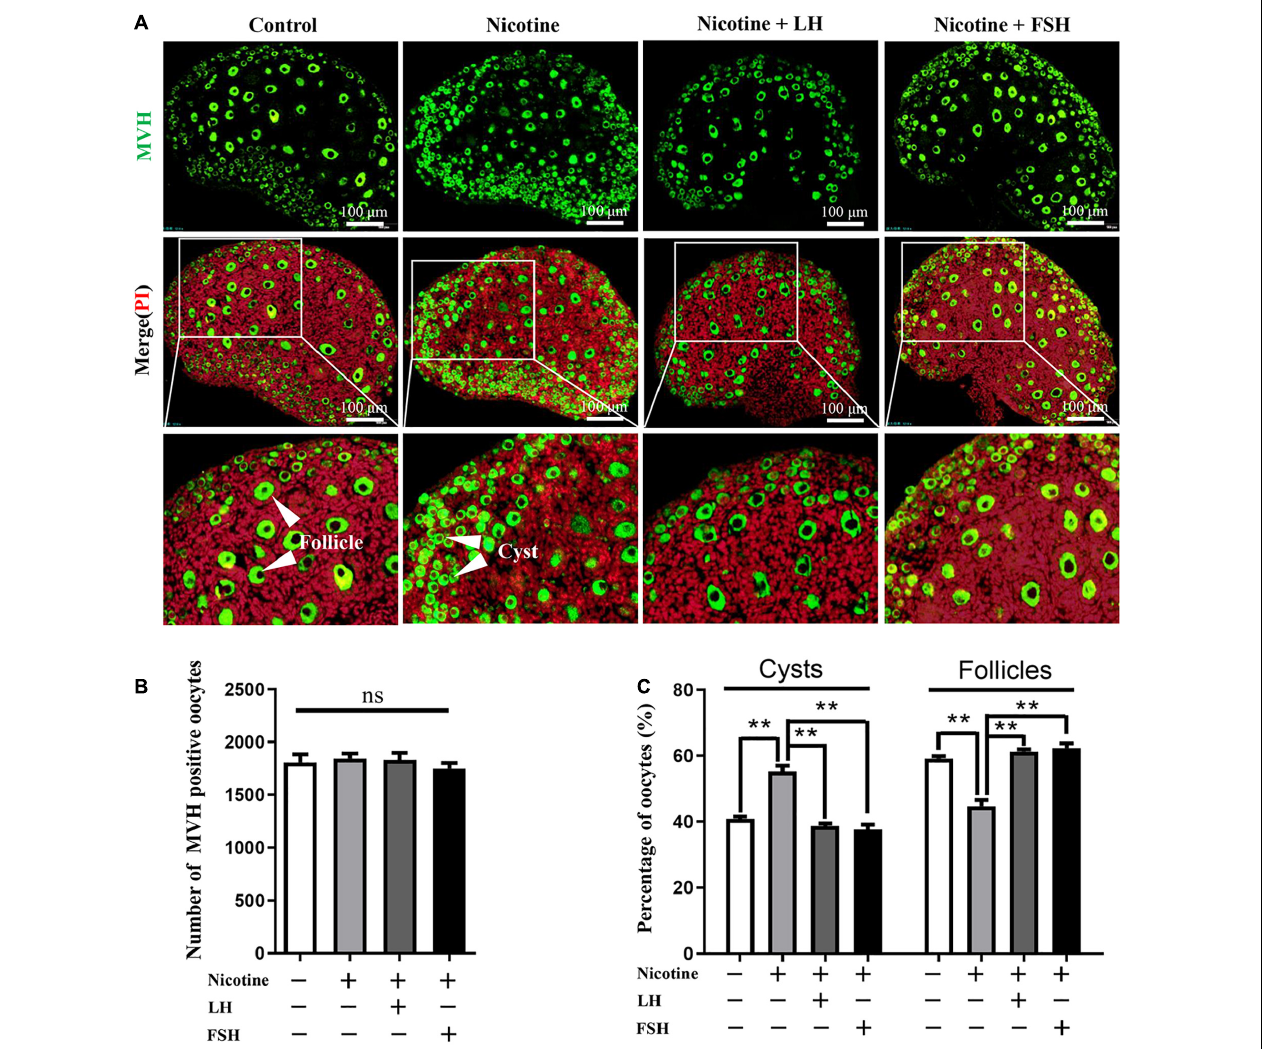
FIGURE 1 | LH and FSH counteract the delay of cyst breakdown in nicotine-exposed ovaries. (A) Representative image of germ cell cyst breakdown and primordial follicle assembly alignment in the control, nicotine, nicotine plus LH, and nicotine plus FSH groups. Scale bar, 100 µ m. (B) The number of MVH-positive oocytes in the ovary in each group. (C) The percentage of oocytes in cysts and follicles in each group. n = 27 newborn female pups in figure and Supplementary Figure 1 . The data are presented as means ± S.E. of three independent experiments (each in triplicate). ** P < 0.01, ns P > 0.05. Abbreviations: LH, luteinizing hormone;